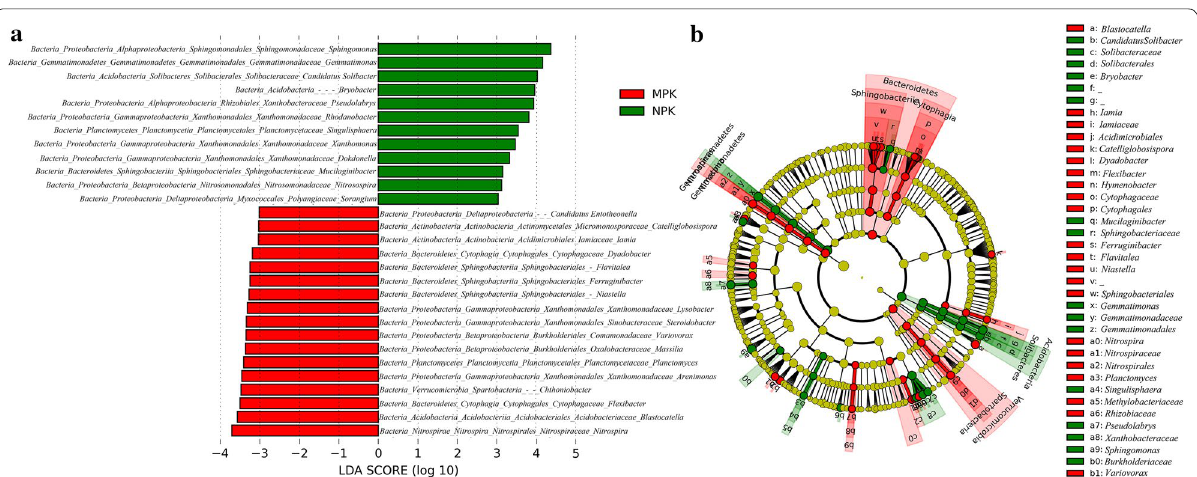
Fig. 3 Bacterial taxa with significantly different abundances between NPK and MPK treatments. a Histogram of LDA scores for features with signifi- cantly different abundance between NPK and MPK treatments. b Taxonomic representation of statistically and biologically consistent differences between NPK and MPK